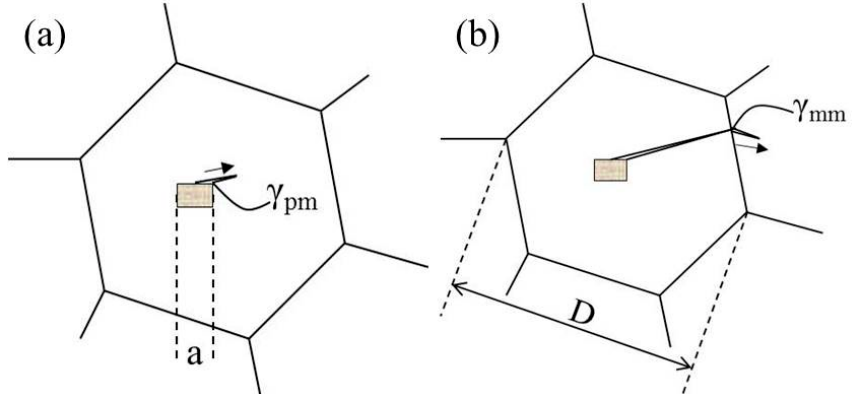
Figure 13. Schematic of the propagation stages of a crack in brittle fracture. ( a ) propagation across the particle–matrix barrier; ( b ) propagation across the matrix–matrix barrier.